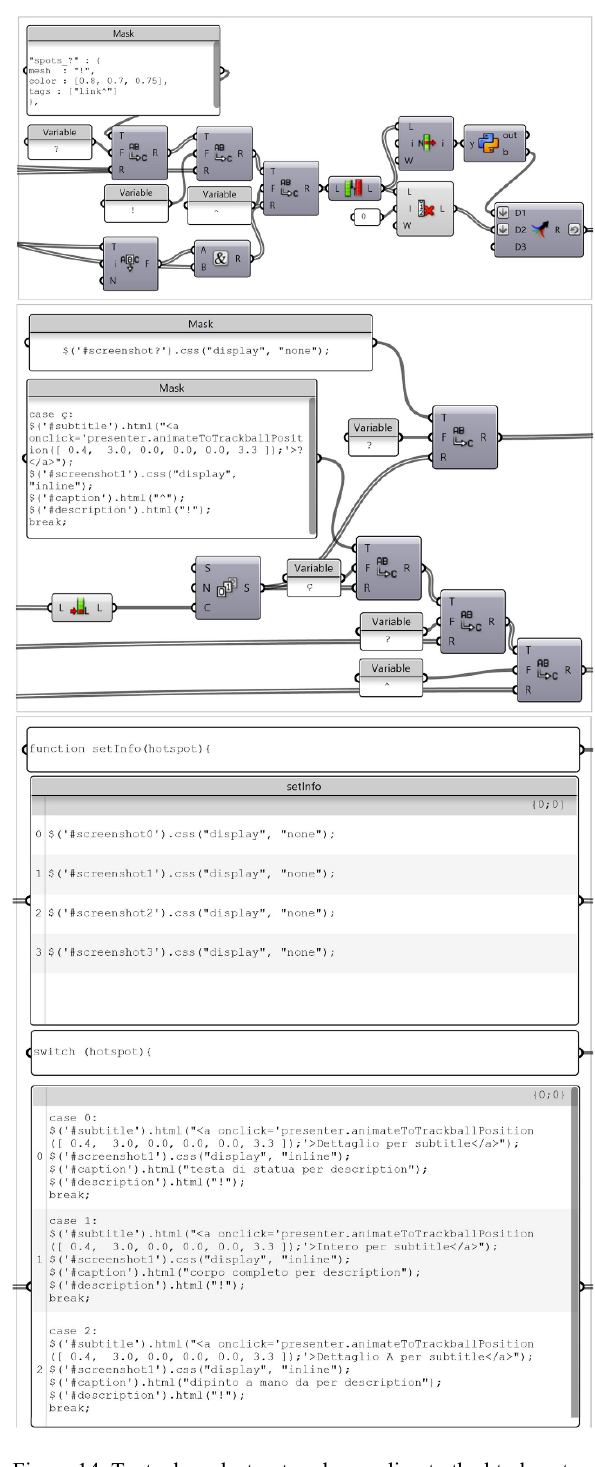
Figure 14. Textual mask structured according to the html syntax to create the consequentiality of the code